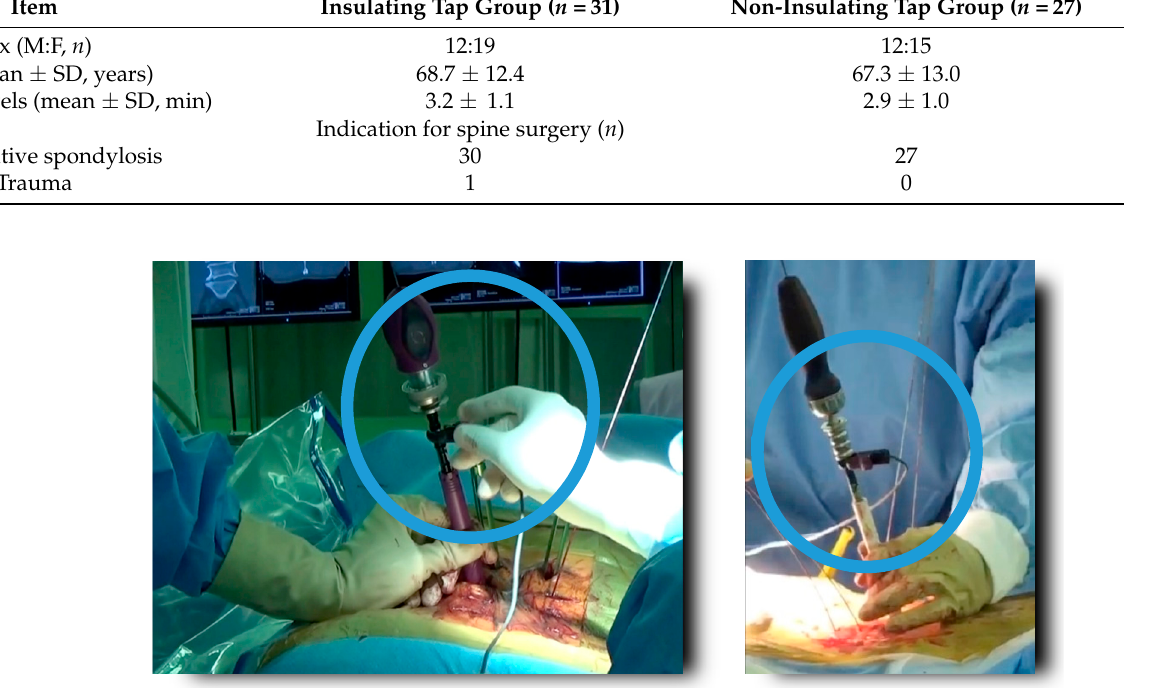
Figure 2. Before inserting the percutaneous pedicle screw, a TrEMG connecting clip was connected to the non-insulated part of the insulating tap and TrEMG was measured (NVM5 ® V2.0 Nerve Monitoring System: NuVasive, San Diego, CA, USA).